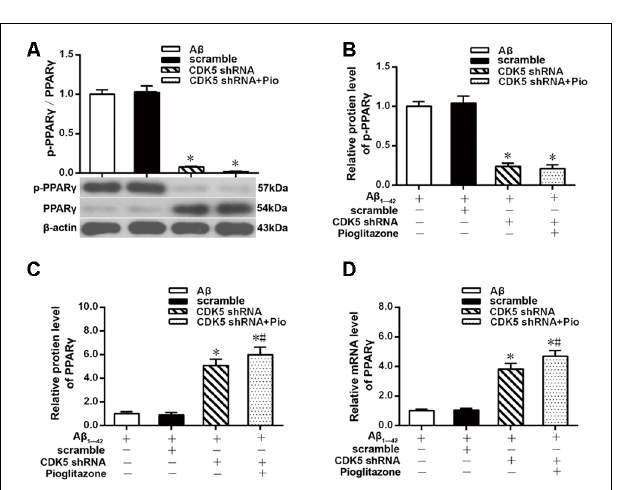
FIGURE 8 | Effects of pioglitazone and A β 1–42 on PPAR γ phosphorylation in AD model neurons after CDK5 silencing. (A) Intergroup comparisons of p-PPAR γ /PPAR γ ratios. (B) Intergroup comparisons of the p-PPAR γ protein levels. (C) Intergroup comparisons of PPAR γ protein levels. (D) Intergroup comparisons of PPAR γ mRNA levels. n = 6 wells per group. ∗ P < 0.05 compared to the A β group, # P < 0.05 compared to the CDK5 shRNA group.